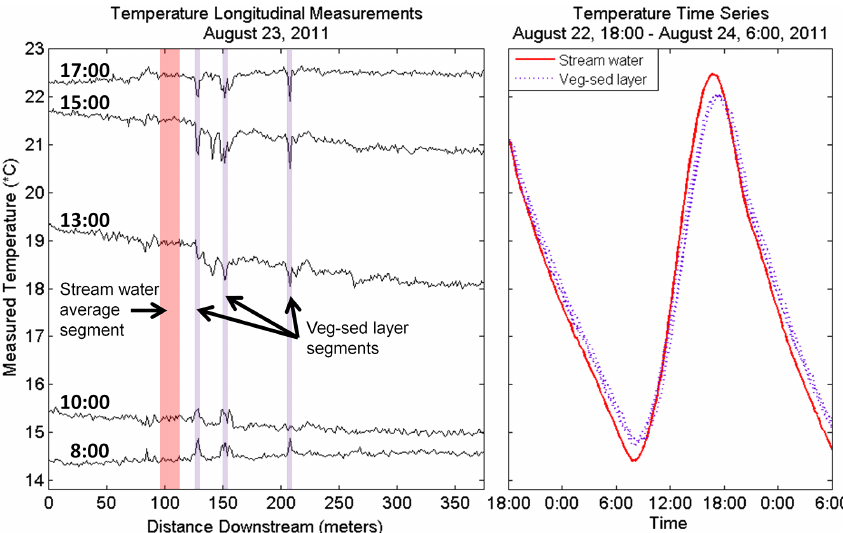
Figure 2. DTS stream temperature measurements taken at 08:00, 10:00, 13:00, 15:00 and 17:00PST (Pacific standard time) along 375m of the Middle Fork John Day River are shown on the left, with segments that intersected vegetation–sediment layers (centered at 129, 152, and 208m downstream) highlighted in purple. On the right, these temperature measurements within the layers were plotted temporally with average ambient stream water temperature (distance-averaged temperature from 96 to 116m downstream).